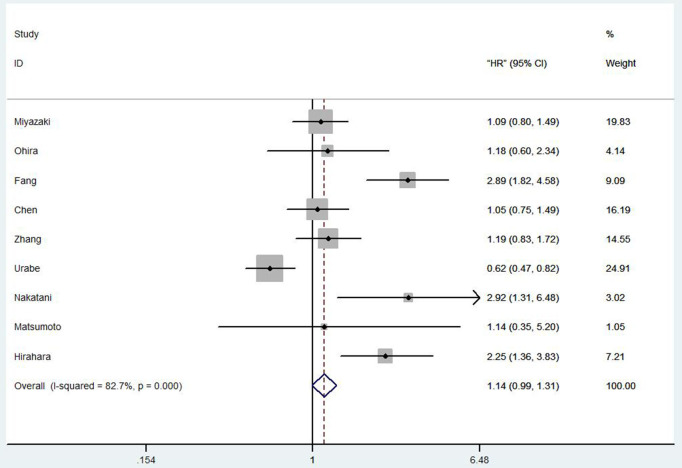
Forest plot of the HR assessing the correlation between the PNI and OS in EC patients. HR, hazard ratio; EC, esophageal cancer; OS, overall survival; PNI, prognostic nutritional index.